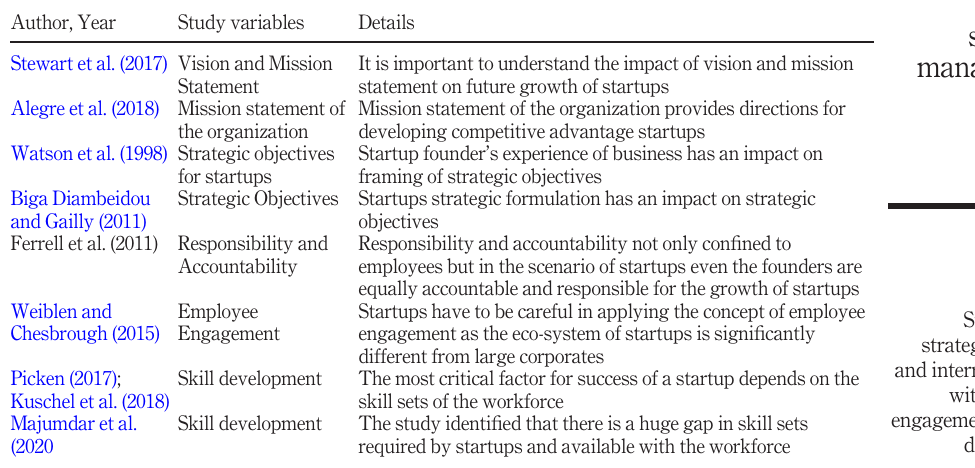
Table 1. Summary